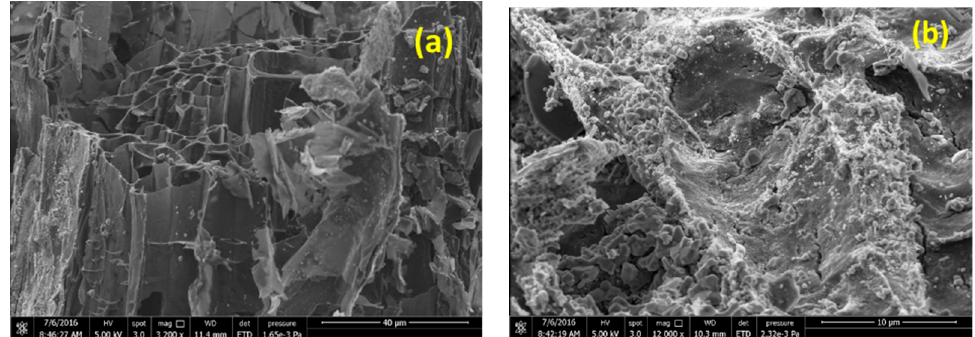
Figure 2. SEM images for a biochar produced from spent malt rootlets at 850 °C. ( a ) The macropores structure of biochar and ( b ) the mineral deposits onto its surface.